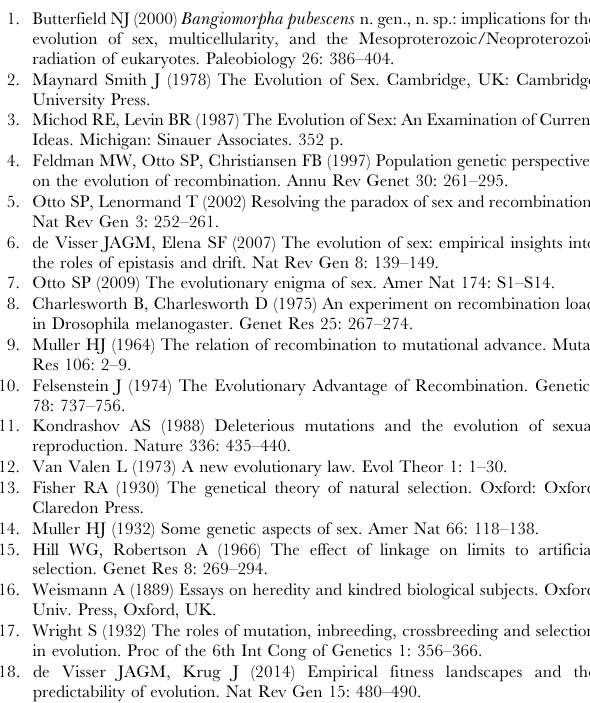
Figure S2 Comparison of the entropy S r and the additive genetic variance V a (A) as well as D S and D V a (B). Parameters are r the same as in fig. 2. All quantities are correlated and show qualitatively the same behavior. Figure S3 Transitory advantage of recombination on Kauff- man’s NK-landscape with L ~ 16 binary loci. Each locus interacts with K adjacent neighbors, and fitness values are drawn from a lognormal distribution. Population parameters are N ~ 1000 and N m ~ 2 . For increasing ruggedness, i.e., for increasing values of K , the advantage becomes less pronounced and vanishes. Data marked ‘HoC’ correspond to the maximally rugged case Figure S8 (A), (C), and (E): Fitness velocities vs. t for systems K ~ L { 1 ~ 15 , where the NK-model reduces to the House of with parameters N ~ 2000 , N m ~ 4 , and c ~ 1 . Intersections are Cards model with uncorrelated random fitness values. marked by dashed lines. (B), (D), and (F): Corresponding curve for D w vs. t . Compare with curves in the schematic pictures in fig. 8. Figure S4 Dependence of the recombinational advantage on population size. Same as fig. 3. but with constant N m ~ 8 and varying population size N . Figure S5 The coefficient of variation c var of the number of mutants that are not located at the most populated genotype when the latter is a local optimum vs. t for systems with r ~ 1 , c ~ 1 , and l ~ 1 . Note that, for constant N m , c var increases with N . Figure S6 Trapping distance increases with landscape dimen- sionality. The figure shows the distance d trap at which populations